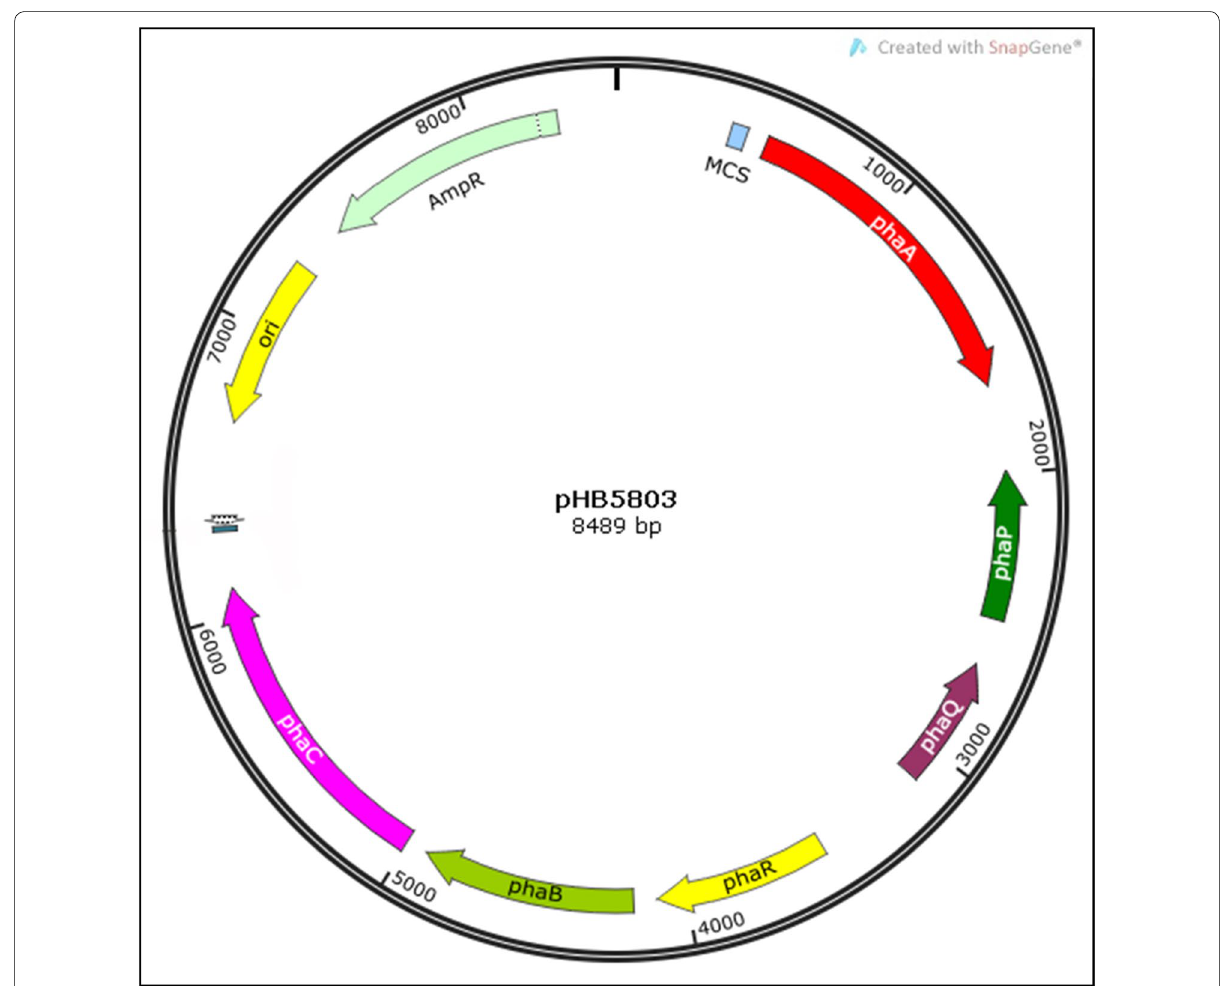
Fig. 1 Physical map of plasmid pHB5803 (Generated using SnapGene software, GSL Biotech, Illinois,